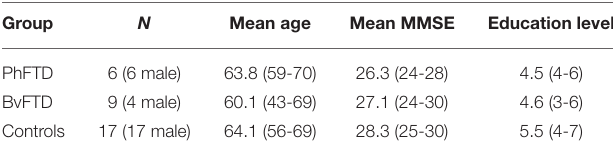
TABLE 2 | Demographic characteristics of baseline reference groups